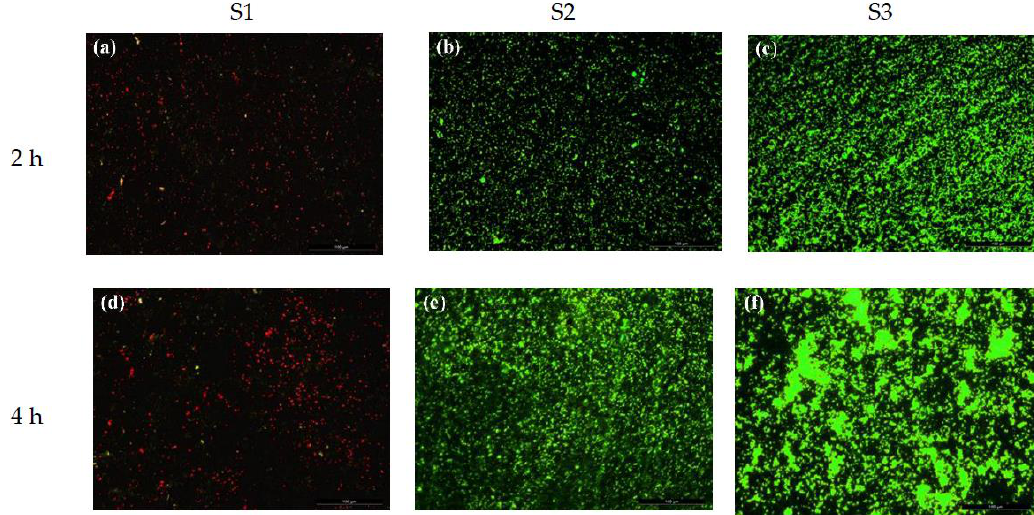
Figure 7. Fluorescence microscopy of Ex-Mg-4Y-1Ag, Ex-Mg, and TC4: ( a – c ) show S1, S2, S3 group cultured for 2 h; ( d – f ) show S1, S2, S3 group cultured for 4